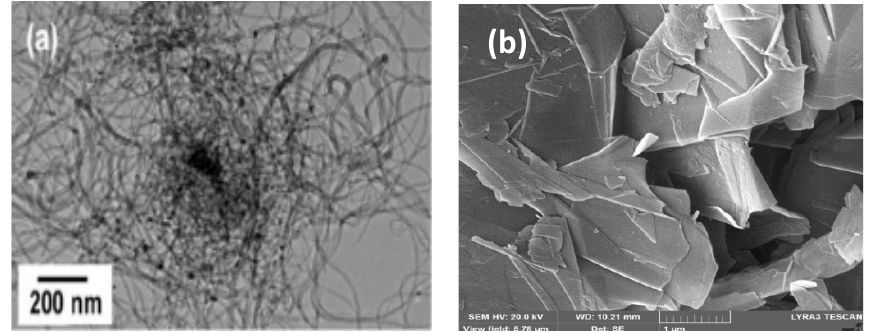
Figure 1. TEM images of ( a ) MWCNT and ( b ) GNF without treatment.